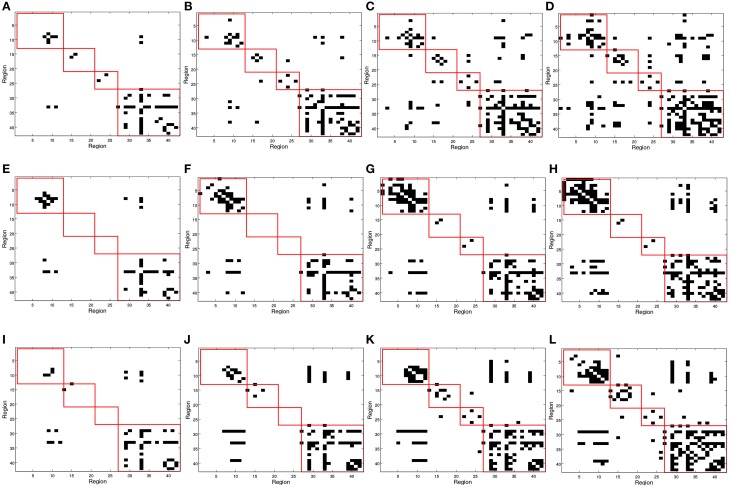
Θ^ matrix computed for (A,E,I) 25, (B,F,J) 50, (C,G,K) 75, and (D,H,L) 100 arcs using structural MRI GM information. First row correspond to Controls, second row corresponds to MCI and third row to AD subjects. Red squares in Θ^ (from top to bottom, left to right) indicates regions contained in frontal, parietal, occipital, and temporal lobes.